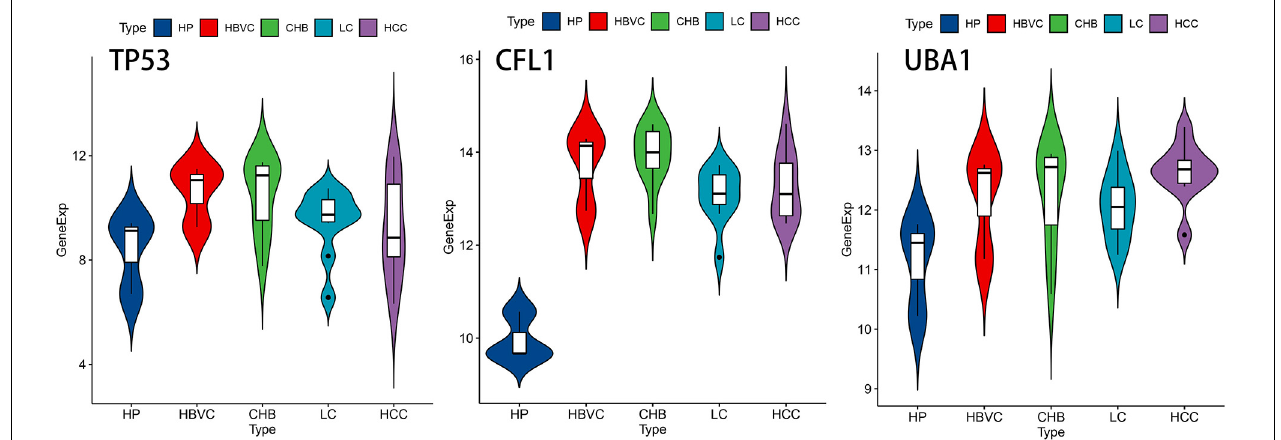
FIGURE 5 | The expression level of TP53 , CFL1 , and UBA1 during multistep hepatocarcinogenesis. Violin plots of the three genes’ expression level during hepatocarcinogenesis on the foundation of dataset GSE114783. HP, healthy people; HBVC, hepatitis B virus carriers; CHB, chronic hepatitis B; LC, liver cirrhosis; HCC, hepatocellular carcinoma.